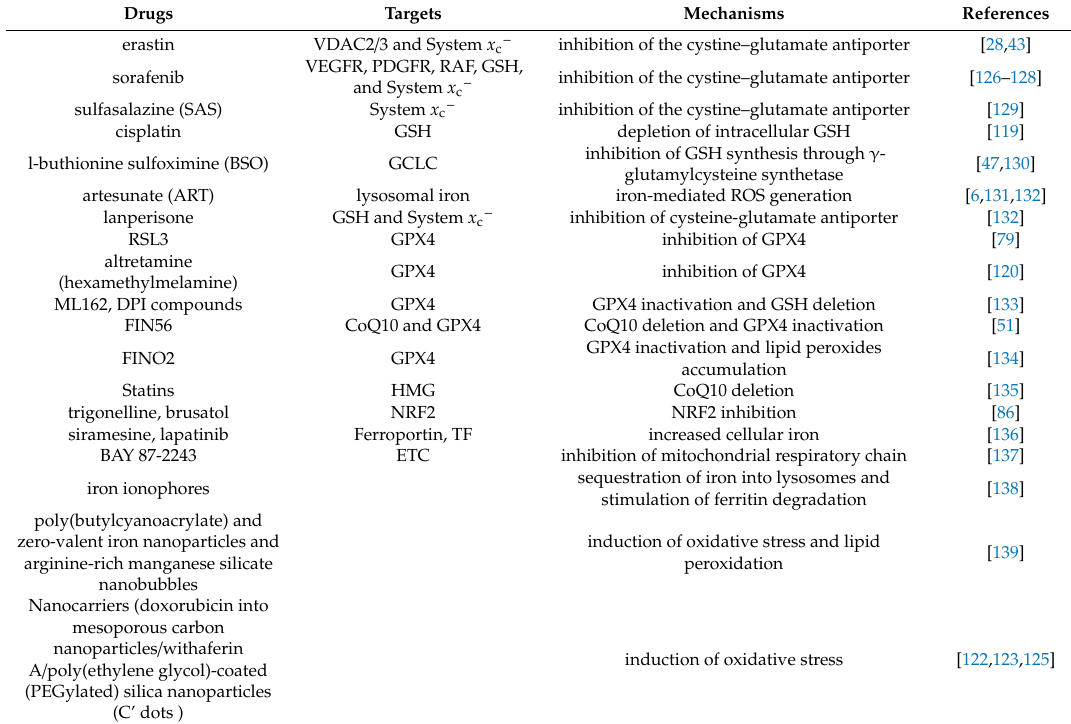
Table 2. Drugs and compounds modulating ferroptosis in cancer